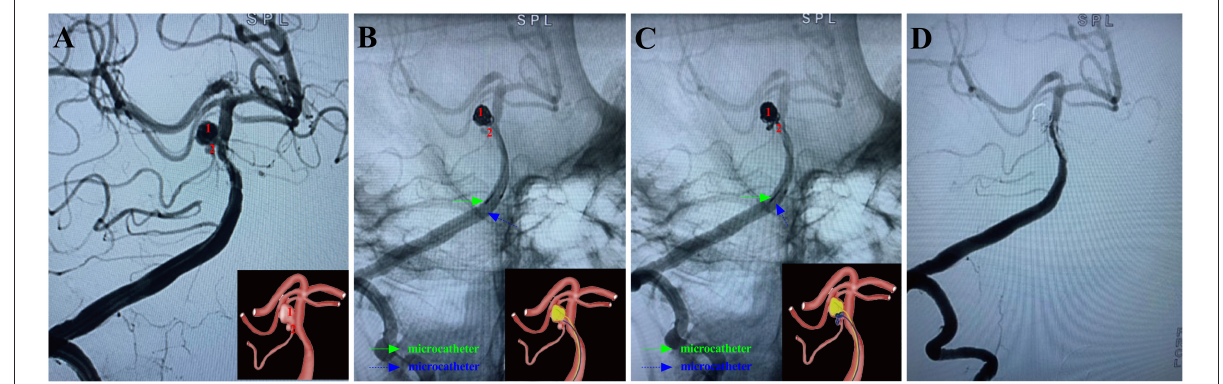
FIGURE5 A ruptured right anterior inferior cerebellar artery aneurysm (Hunt-Hess grade III) in a 59-year-old female was treated using the MCP technique. Arabic numerals indicate the ascus of an IA. (A) Right vertebral artery digital subtraction angiography (working angle) showed an irregular aneurysm with a daughter sac at the bifurcation of the basilar artery and right superior cerebellar artery. (B) Double-coil microcatheters (blue and green arrows) were introduced in different sacs of the IA. Embolization was first performed with a microcatheter (green arrow) navigating into the upper daughter sac and coils packing (image of digital non-subtraction angiography). The other microcatheter completed the remaining part of the bottom of the aneurysm sac (blue arrow). (C) The other microcatheter completed the remaining part of the bottom of the aneurysm sac (blue arrow). After packing the upper sac, the microcatheter (blue arrow) enters the lower sac. Subsequently, the lower daughter sac was coiled (blue arrow). (D) Post-embolization digital subtraction angiograms at the working angle exhibited complete occlusion at Raymond grade I. The inserts in the lower right corner illustrated an aschematic diagram of the MCP process of the IA (A–C)